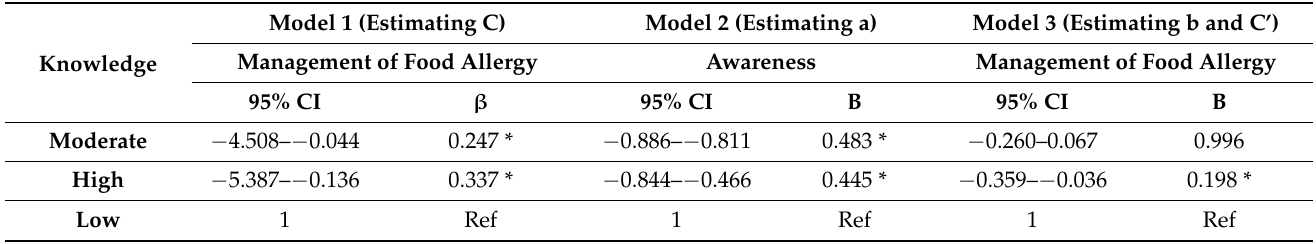
Table 6. Effect of mediation by awareness on relationship between knowledge and management of food allergy.